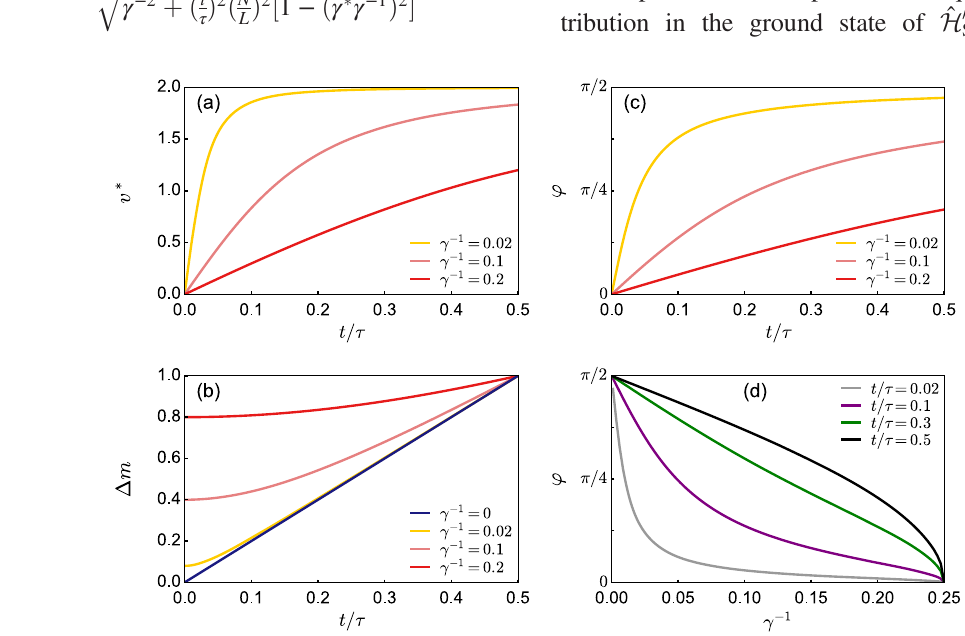
FIG. 7. Site and quasimomentum occupations of noninteracting spinless fermions for N=L ¼ 1 = 2 . (a) Velocity of the propagating front v (cid:3) ð t Þ [Eq. (D1)]. (b) Amplitude of the quasimomentum distribution function for noninteracting fermions Δ m ð t Þ [Eq. (D2)]. (c),(d) Position of the peak of the quasimomentum distribution function φ ð t Þ [Eq. (D4)]. Results are shown versus t= τ in (a) – (c), and versus γ − 1 in